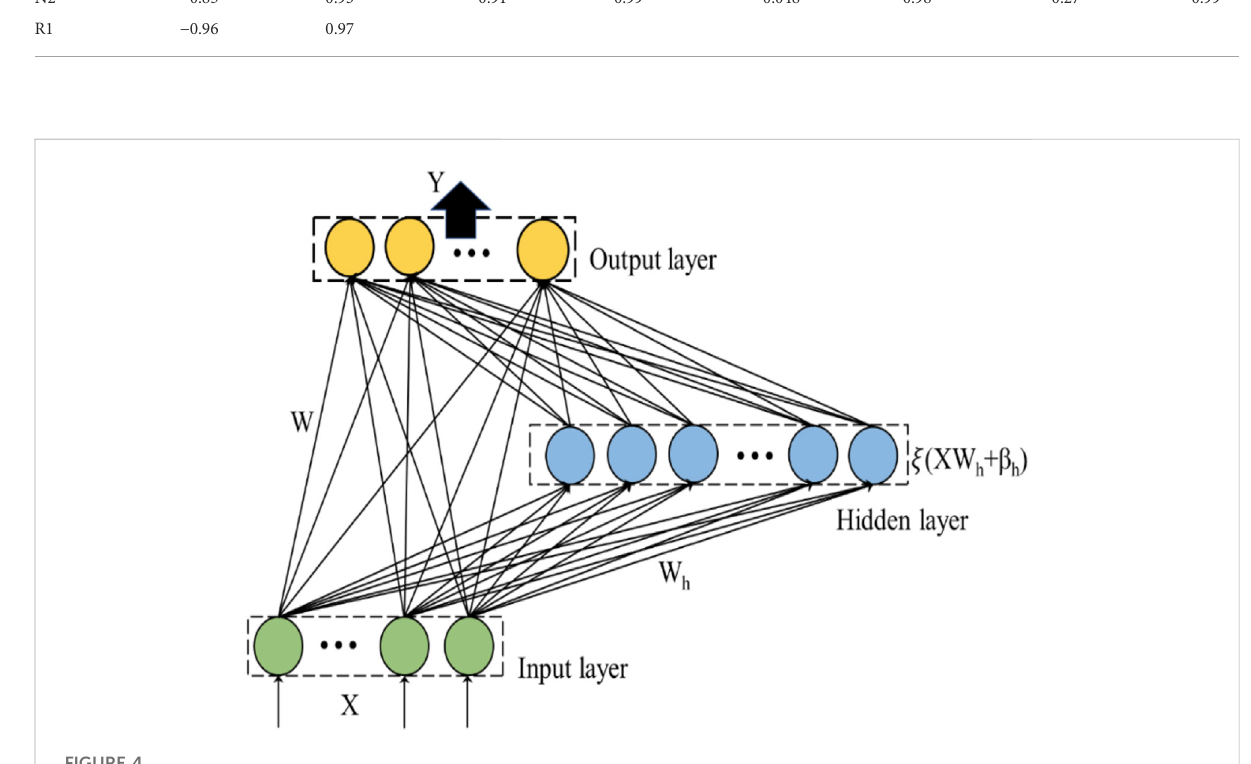
FIGURE 4 The architecture of